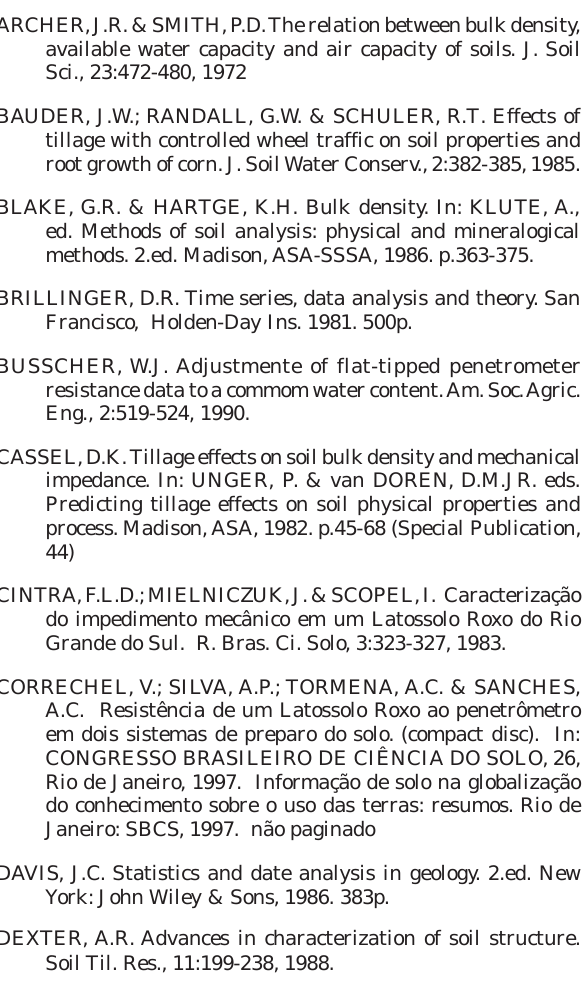
3,9 MPa, na entrelinha, e 0,5 MPa na linha. O